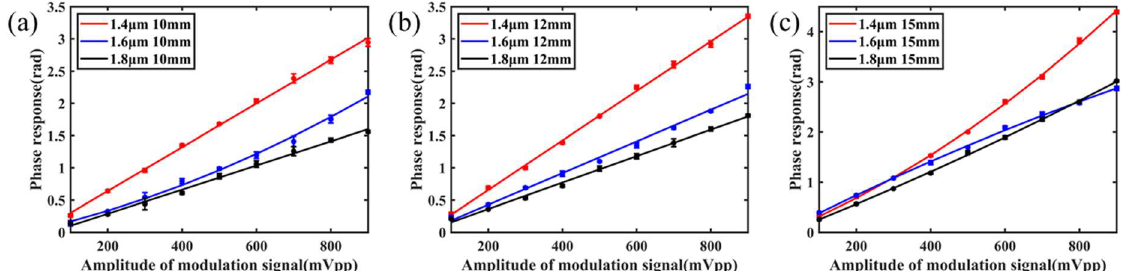
Figure 7. Amplitude response of the OM phase modulator with different structural parameters; the lengths are the same as ( a ) 10 mm, ( b ) 12 mm, and ( c ) 15 mm.